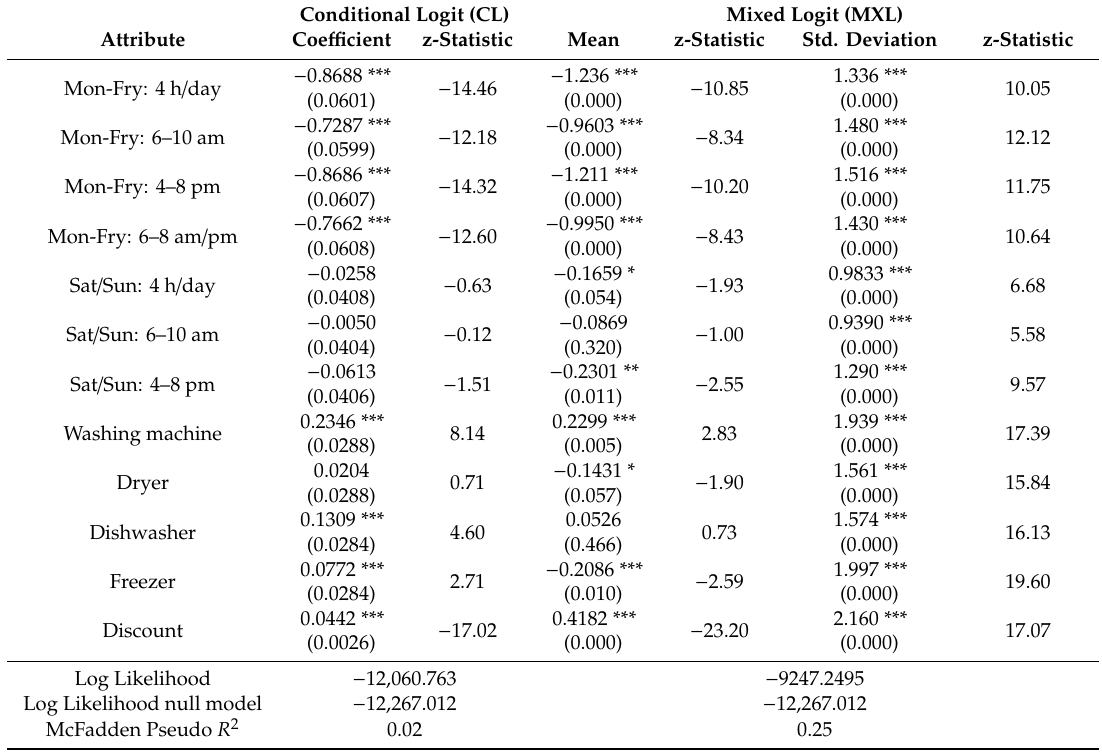
Table 4. Estimation of choice